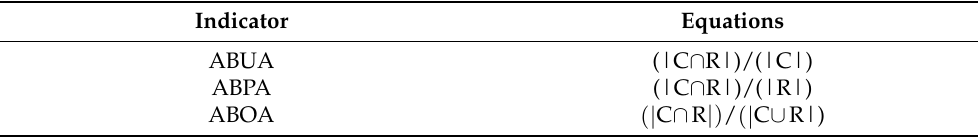
Table 3. Area-based accuracy assessment equations.